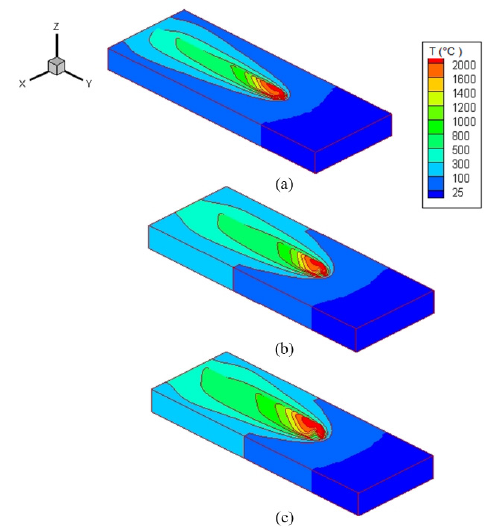
Figure 5. 3D numerical simulation: a) 0.6 kJ mm –1 b) 1.6 kJ mm –1 and c) 2.6 kJ mm –1